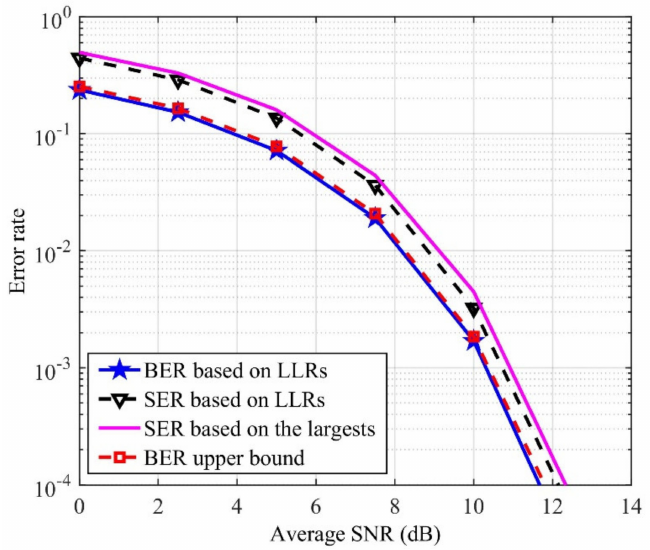
Figure 3. Bit error rate and symbol error rate of the (5, 2) MPPM UWOC system in the absence of